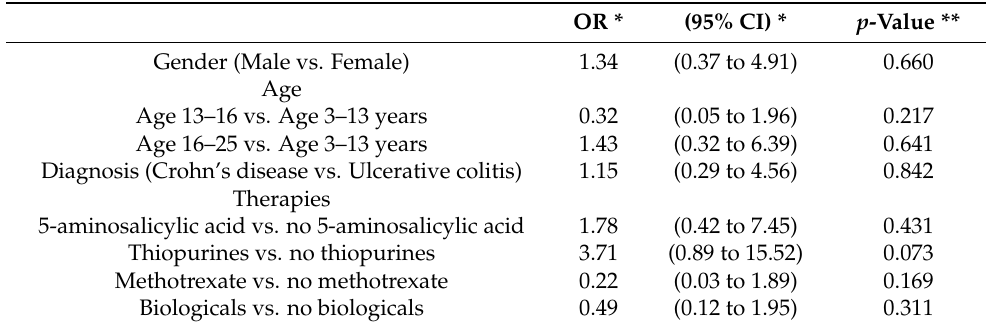
Table 3. Univariate logistic regression model for factors associated with EBV seroconversion after IBD diagnosis ( n =